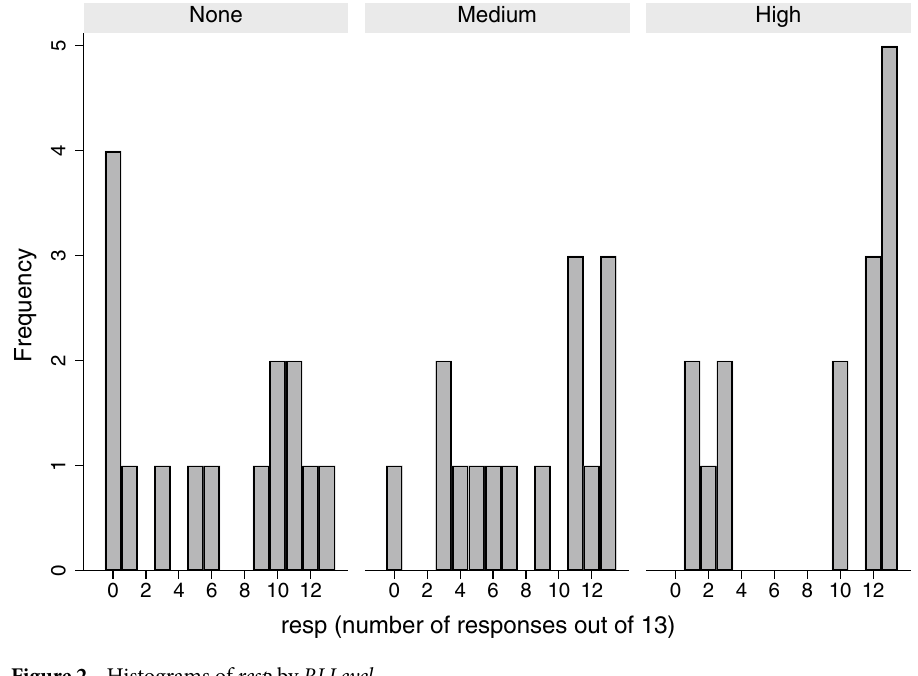
Figure 2. Histograms of resp by RLLevel.